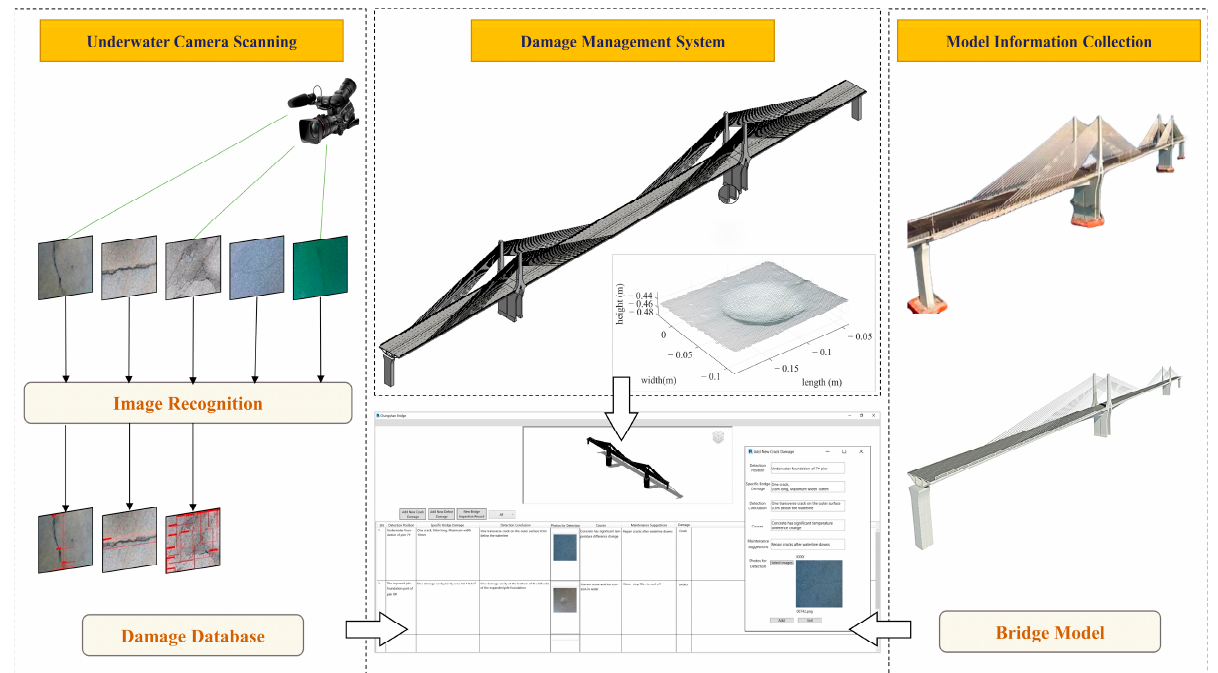
Figure 12. System Framework.